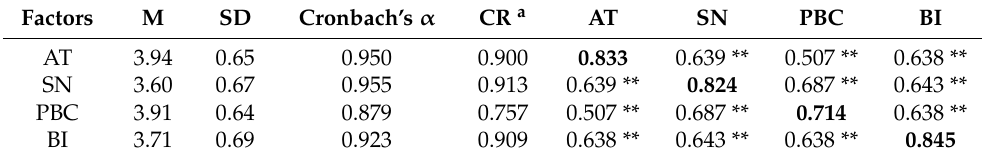
Table 3. Means, standard deviations, reliability, and validity of the study